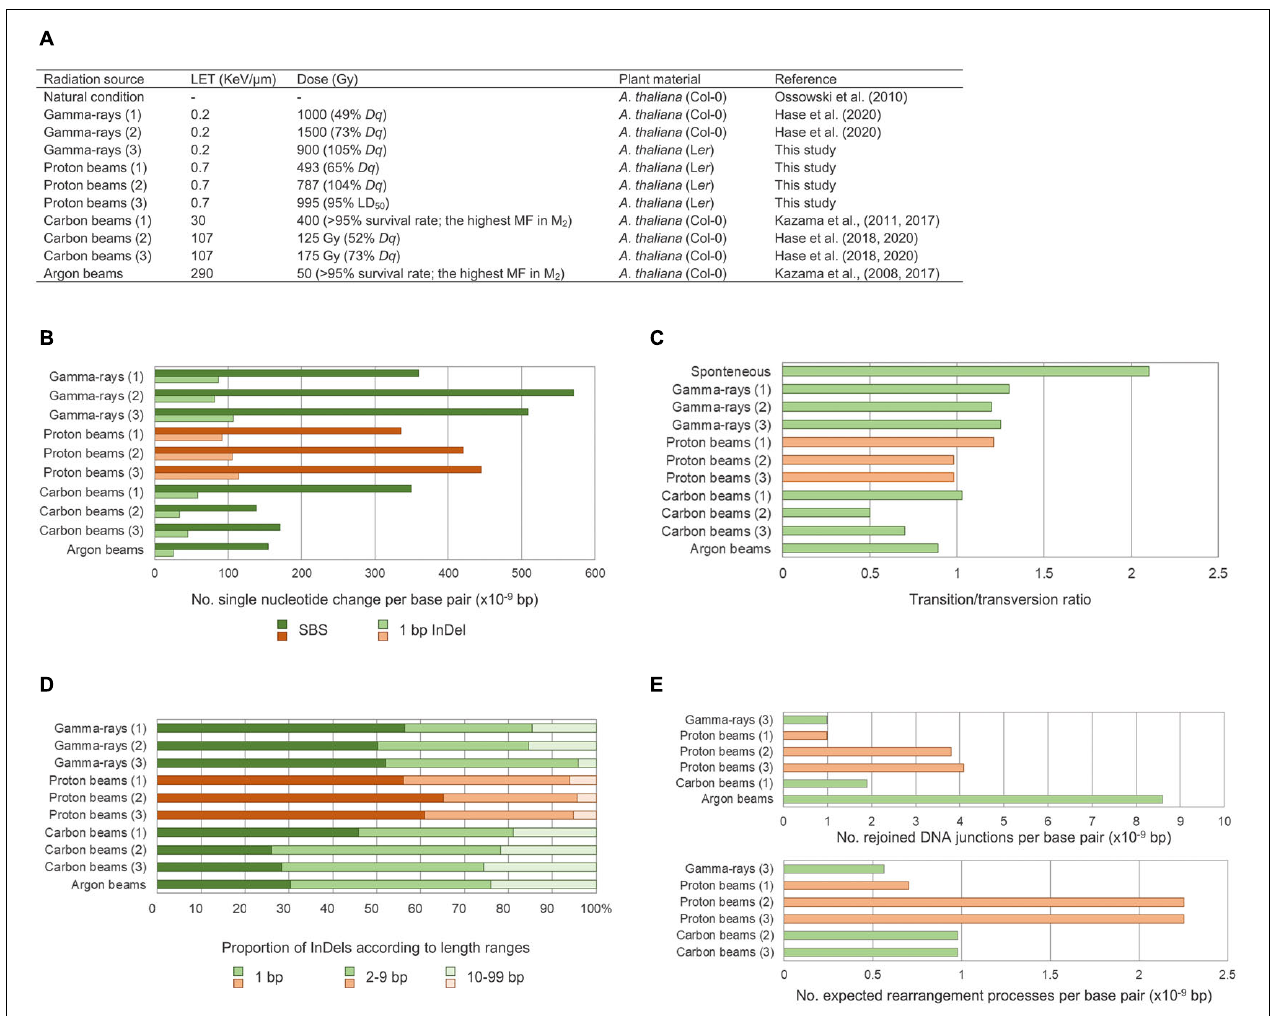
FIGURE 8 | Comparison of mutagenic effects according to radiation sources and irradiation doses. (A) Irradiation conditions and samples in this study and in previous studies that used Arabidopsis M 2 lines. (B) Frequency of single nucleotide variations including single base substitutions (SBSs) and 1-bp deletions. (C) Transition-to-transversion ratios. (D) Proportions of small InDels classified according to their sizes. (E) Frequency of structural variations (SVs). The number of rejoined DNA junctions found in this study were compared with the number found by Kazama et al. (2017), and the number of expected rearrangement events found in this study were compared with the number found by Hase et al. (2018, 2020) so that the data could be used as they were represented in each of the previous studies. Red and green bars represent plant groups derived from proton beam irradiation and other types of irradiations,